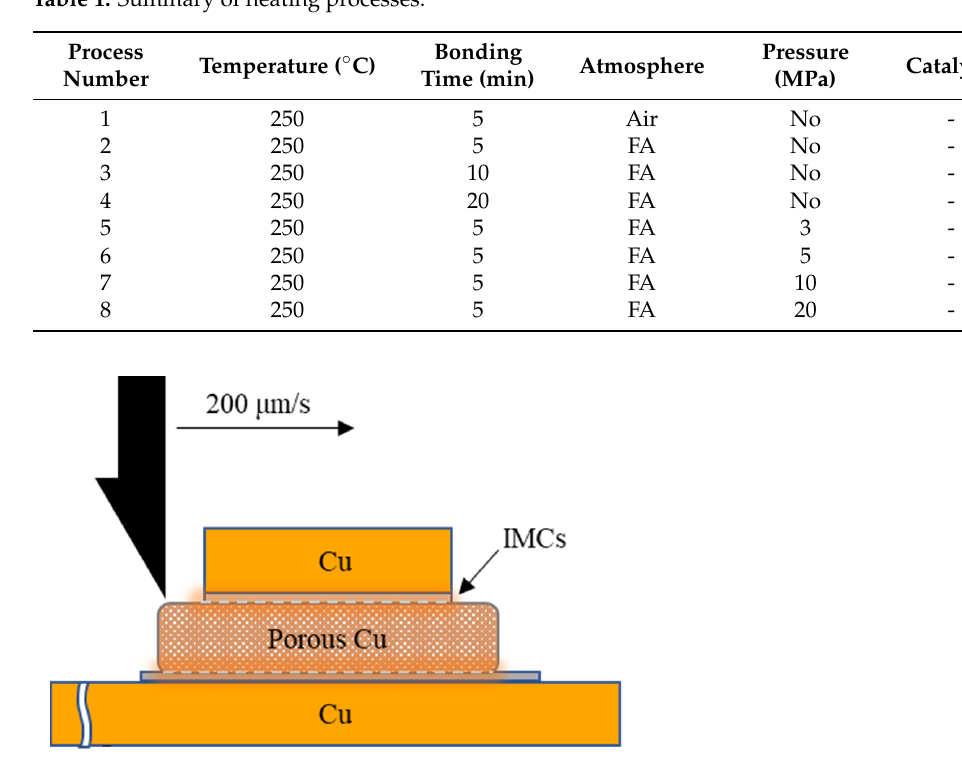
Figure 2. Schematic diagram of shear strength test.